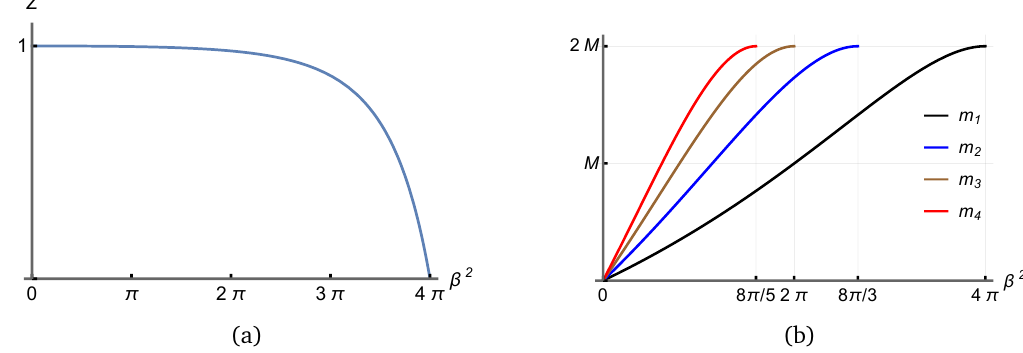
Figure 4.8: The wave-function renormalisation factor (a) and the masses of the first four breathers (in units of the soliton mass M ) (b) as functions of the coupling β in sine–Gordon